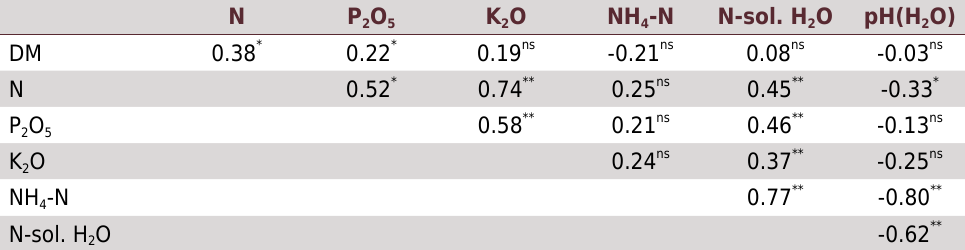
Table 2. Pearson correlation coefficients (r) between chemical attributes from poultry litter samples (1)